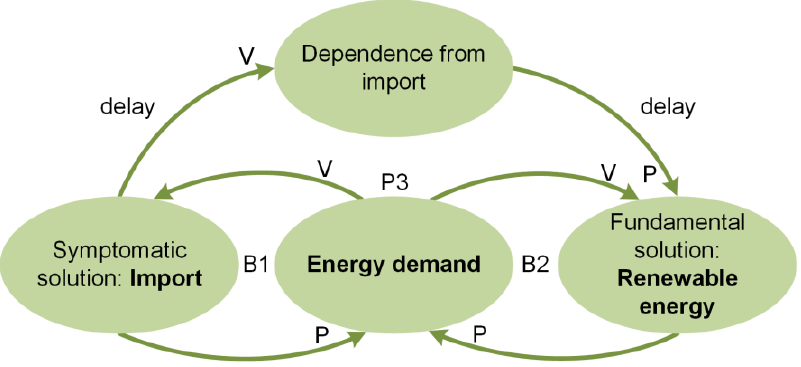
Fig. 2. System’s archetype “distraction” (P – contrary processes, V – equal processes, B1, B2 – balancing loops, P3 – balancing